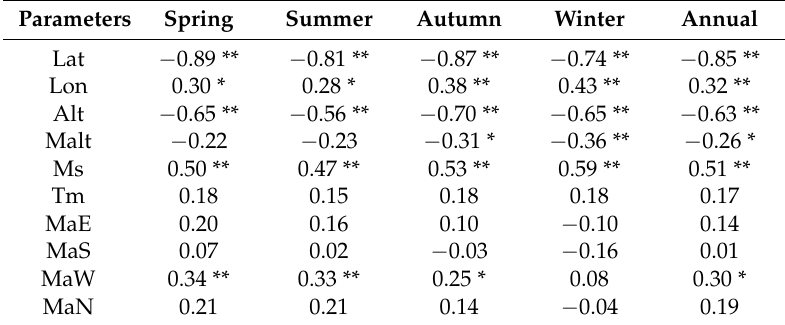
Table 3. Same as Table 2, but for stations with an elevation below 1700 m.